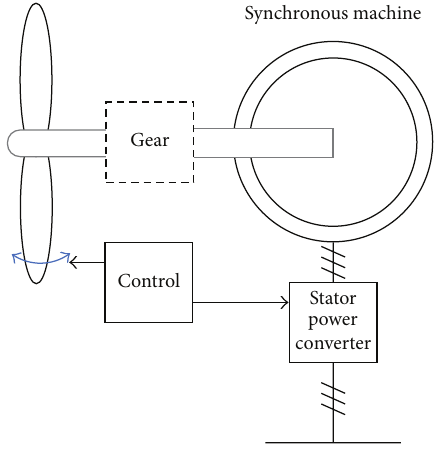
Figure 1: Wind turbine model in SIMPOW